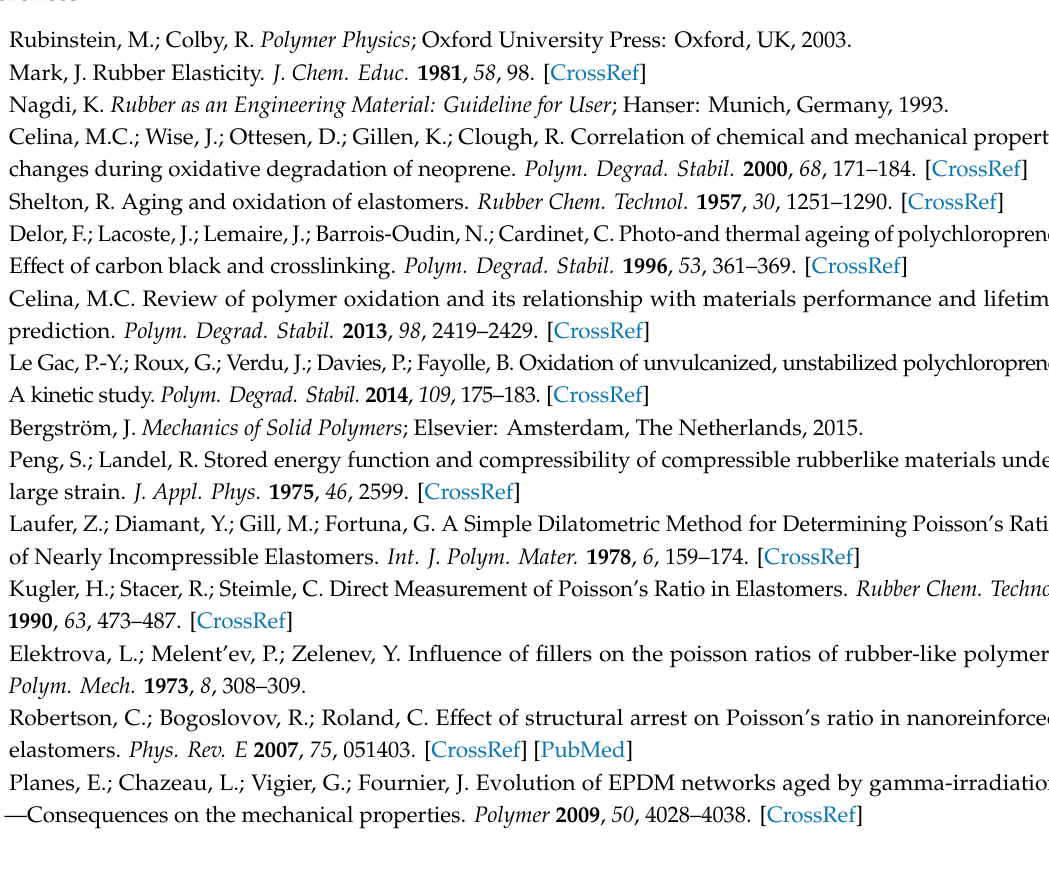
Figure A2. FTIR spectra of neoprene aged at 90 °C for different durations.